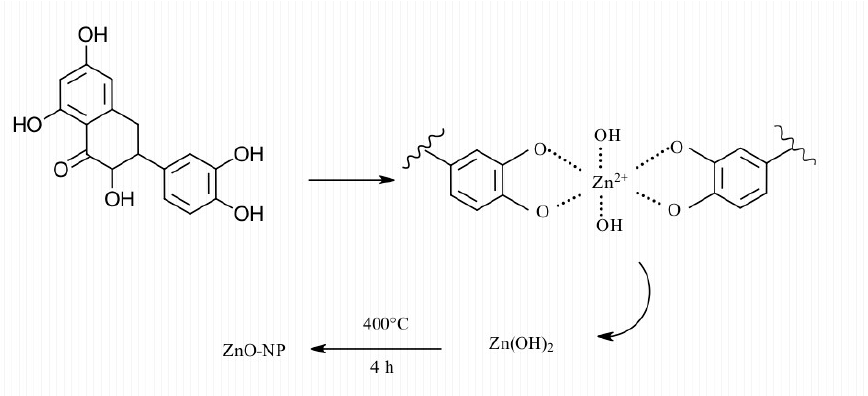
Figure 8. The proposed mechanism for ZnO-NPs formation.